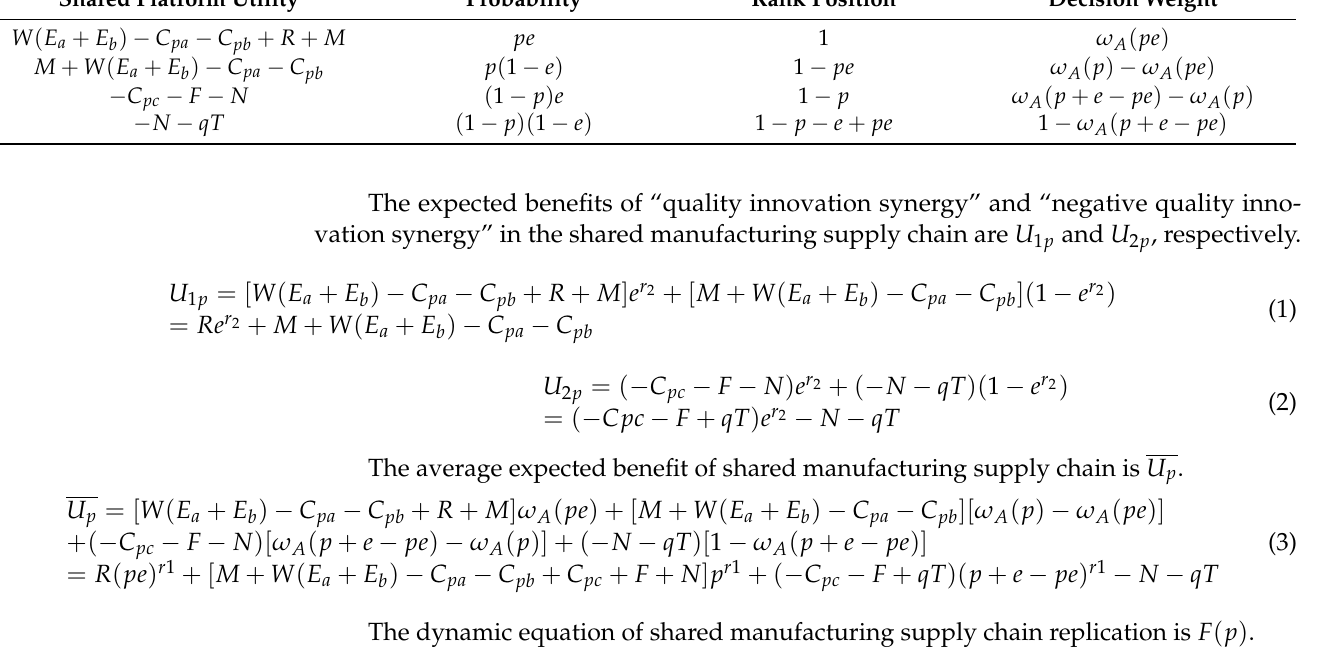
Table 3. RDEU of shared manufacturing supply chain considering emotions. Shared Platform